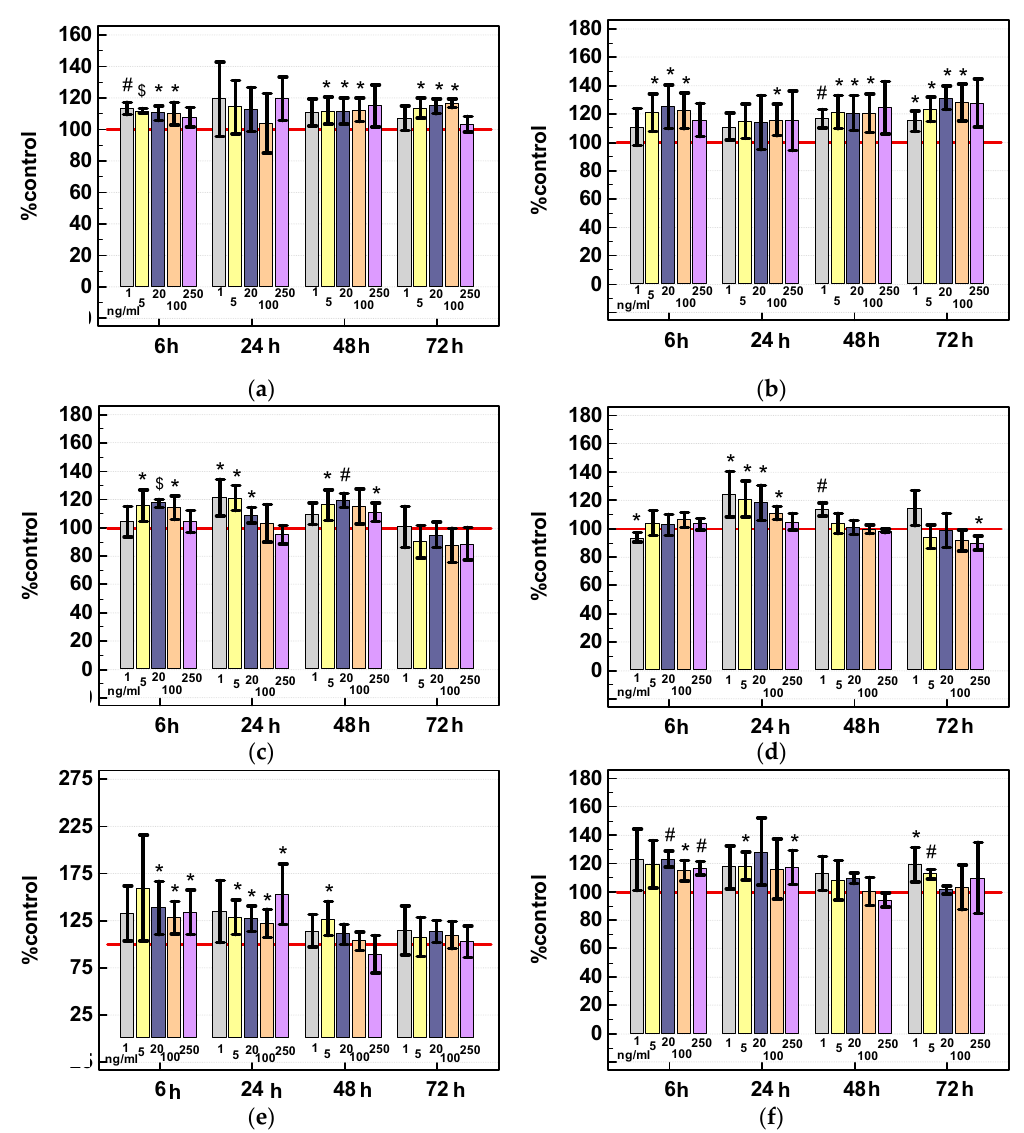
Figure 13. Effect of exogenous IL-4 (1–250 ng/mL) on cancer cell viability under normal (10% FBS) and nutritional-stress (0.5% FBS) conditions as determined with sulforhodamine B (SRB) assay: ( a ) HCT 116 cultured in 10% FBS; ( b ) HCT 116 cultured in 0.5% FBS; ( c ) HT-29 cultured in 10% FBS; ( d ) HT-29 cultured in 0.5% FBS; ( e ) Caco-2 cultured in 10% FBS; ( f ) Caco-2 cultured in 0.5% FBS. Data presented as percentage (% control) of viability of unstimulated cells, marked at 100% as reference red horizontal line. Statistically significant differences in treated cells as compared to their respective controls, analyzed using t -test for one mean, are marked as follows: p < 0.05 as *; p < 0.01 as #; p < 0.001 as $. Bars represent means ± SE of at least three experiments. FBS, fetal bovine serum.